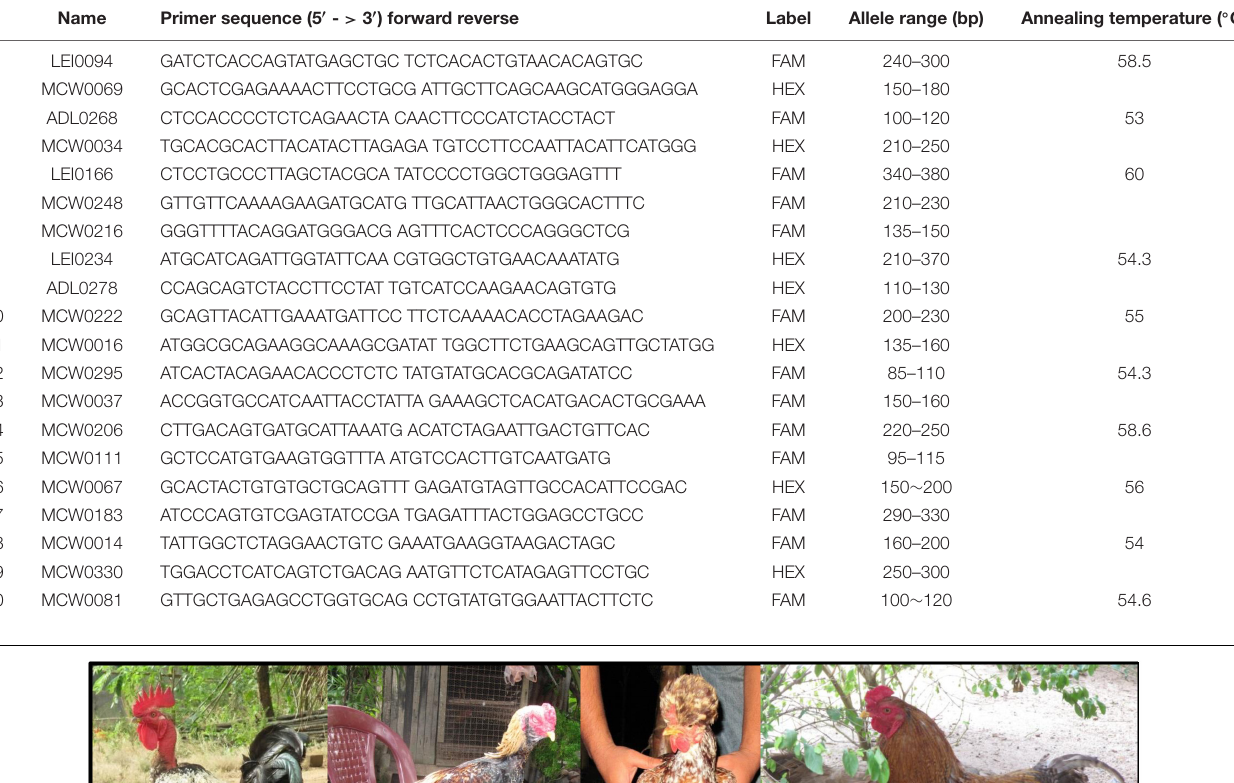
TABLE 2 | Primer name, primer sequence, allele size, and annealing temperature of 20 microsatellite markers used for the analysis.